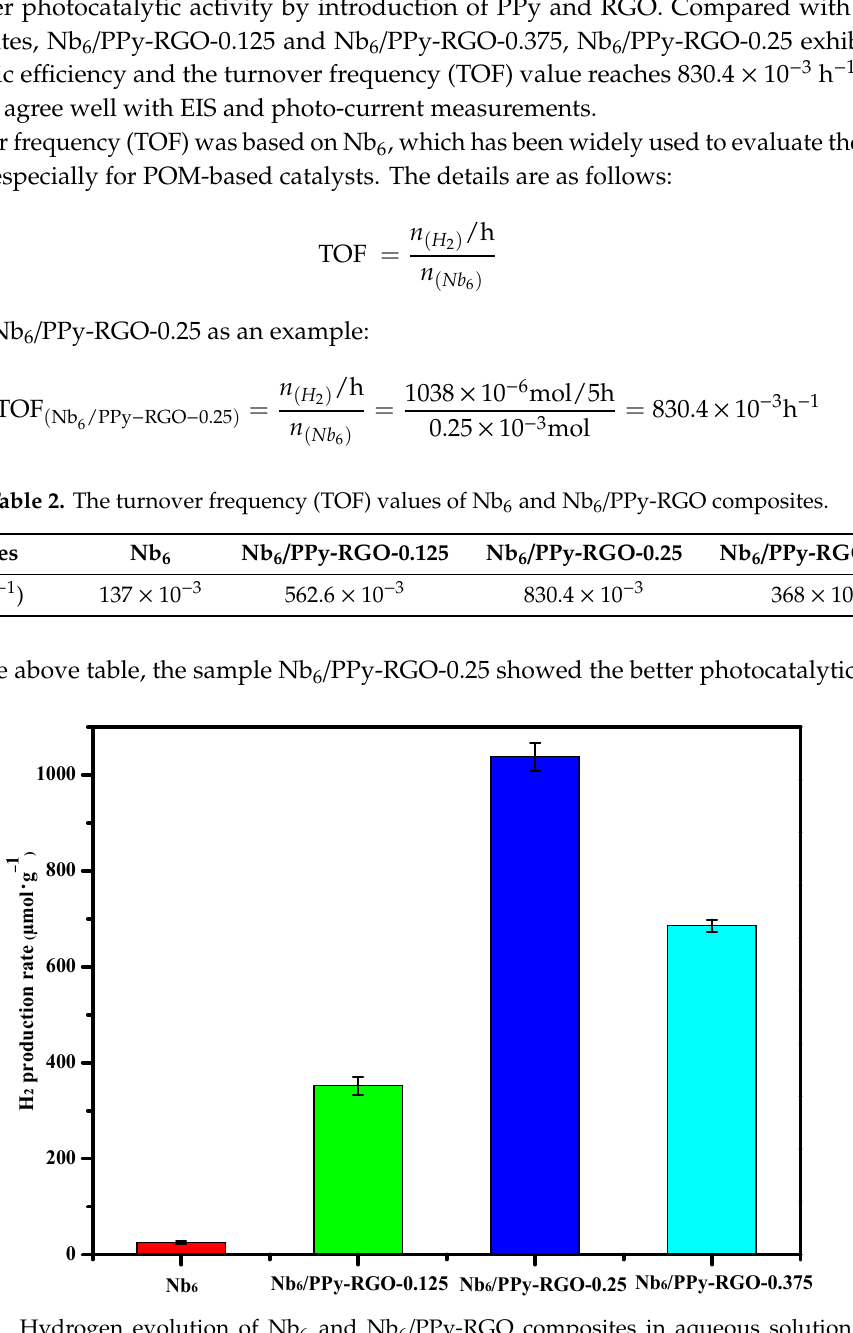
Figure 8. Hydrogen evolution of Nb 6 and Nb 6 / PPy-RGO composites in aqueous solution with MeOH 20%.